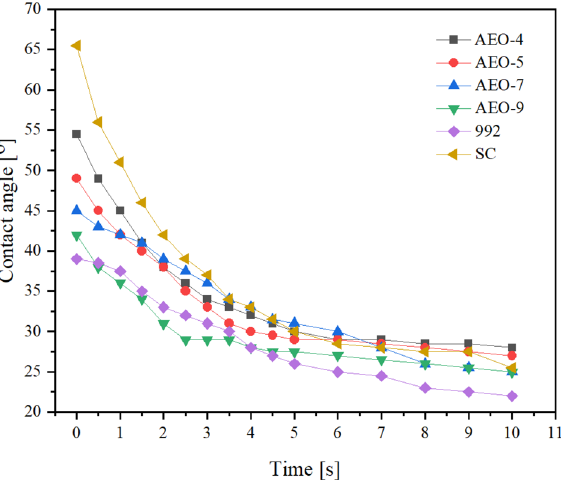
Figure 2. Contact angles of different samples on cotton leaves in 0–10 s. The detailed data of drawing the contact Angle curve is shown in Supplementary Table S2.